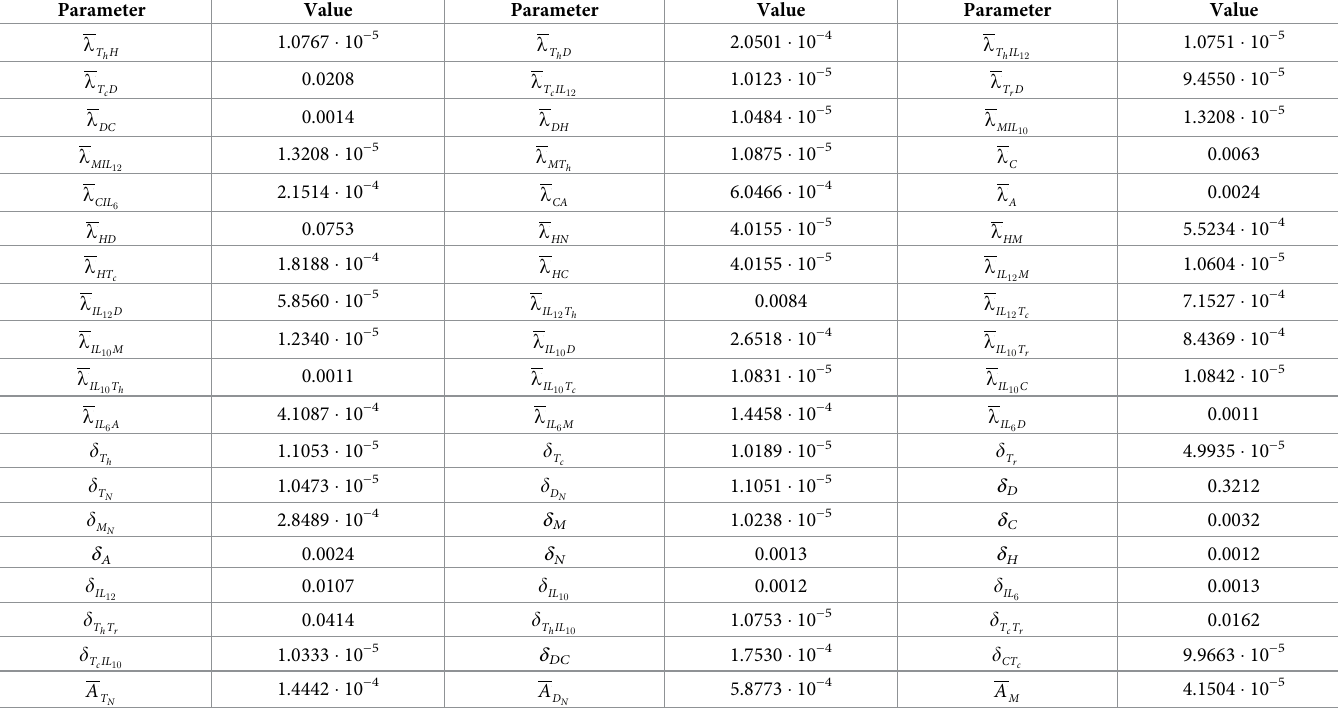
Table 3. Non-dimensional parameter